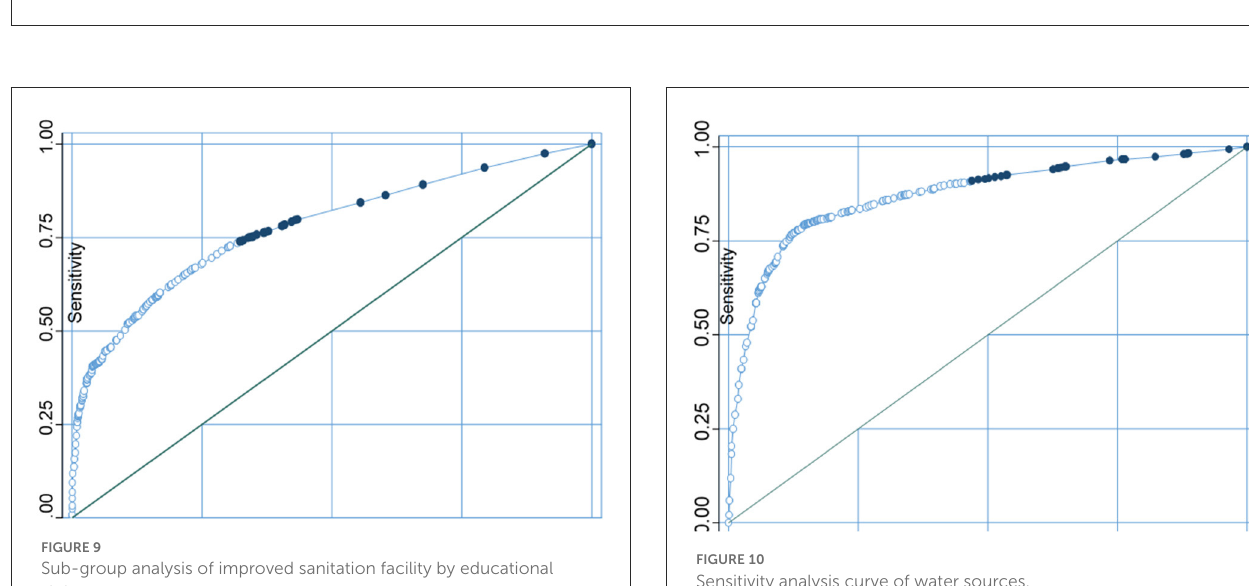
FIGURE8 Sub-group analysis of improved sanitation facility by geographic location.